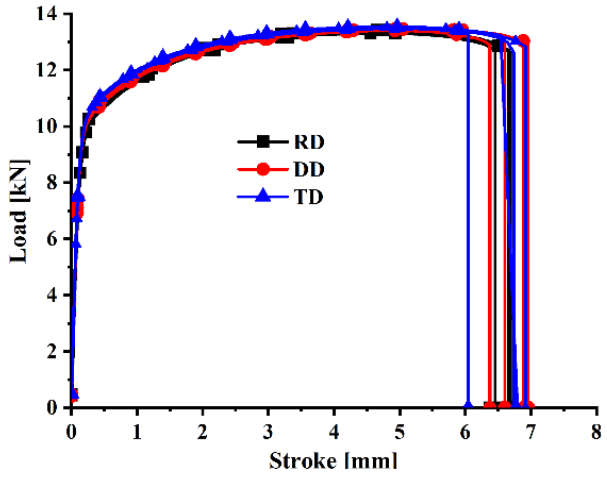
Figure 2. Stroke-load curves along different directions for dog-bone specimens.